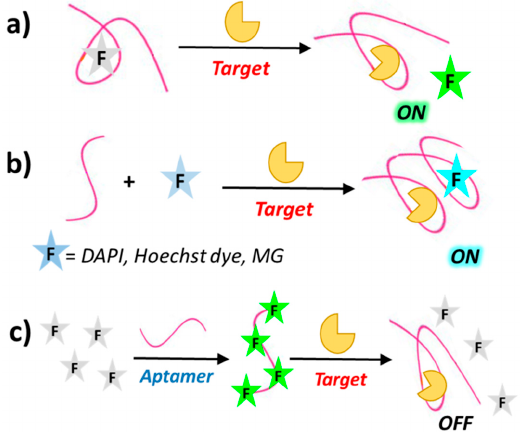
Figure 5. Schematic representation of different strategies exploited in the development of label-free aptamer biosensors, based on “signal-on” mode, after fluorophore displacement ( a ) or fluorophore binding ( b ) and “signal-off” mode after fluorophore displacement ( c ), induced by target recognition. DAPI = 4 (cid:48) ,6-diamidino-2-phenylindol; MG = malachite